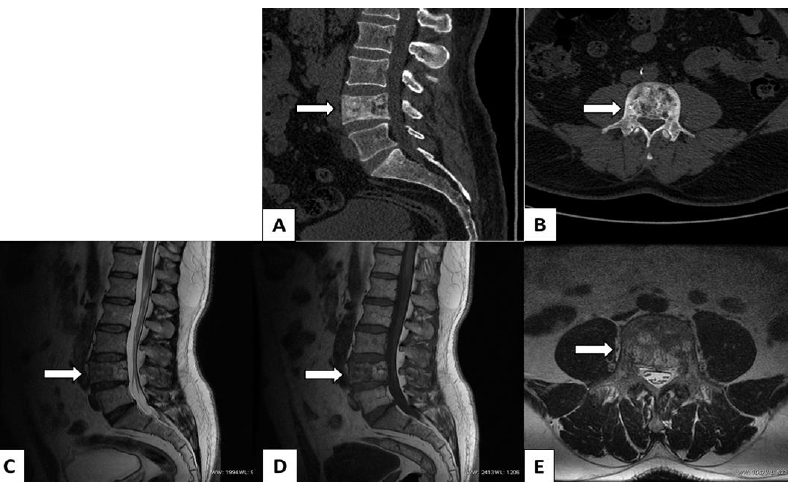
Figure 1. Computed tomography angiography (CTA) and magnetic resonance imaging (MRI): ( A ) Sagittal CT image, bone window, reveals mildly enlarged and “squared” L4 (arrow) vertebral body. The vertebral body is mostly sclerotic with cortical thickening and disorganized, coarsened vertical trabeculae. ( B ) Axial CT image, bone window, shows heterogenous sclerotic remodeling and end enlargement of the L4 vertebra with sclerotic cortical thickening. Changes also affect the vertebral pedicles and the neural arch of the vertebra. ( C , D ) Sagittal MRI T1-weighted image (T1WI) and T2WI of the lumbar spine reveal enlargement of the L4 vertebral body with mild vertebral canal stenosis. The L4 vertebral body is “squared” and shows loss of the anterior concave margin. Heterogeneous change of bone marrow signal of the affected vertebral body. In the anterior part, the low signal on T1WI and T2WI suggests sclerosis-fibrosis and late, blastic inactive phase of Paget’s disease of bone (PDB). In the posterior part, the high signal on T1WI and T2WI suggests fatty marrow of mixed (second) phase of PDB. ( E ) Axial MRI T2WI image shows an enlargement of the vertebral body and pedicles, heterogeneous bone marrow remodeling with thickened trabeculae, and patchy areas of high signal in the posterior part, suggesting fatty transformation.